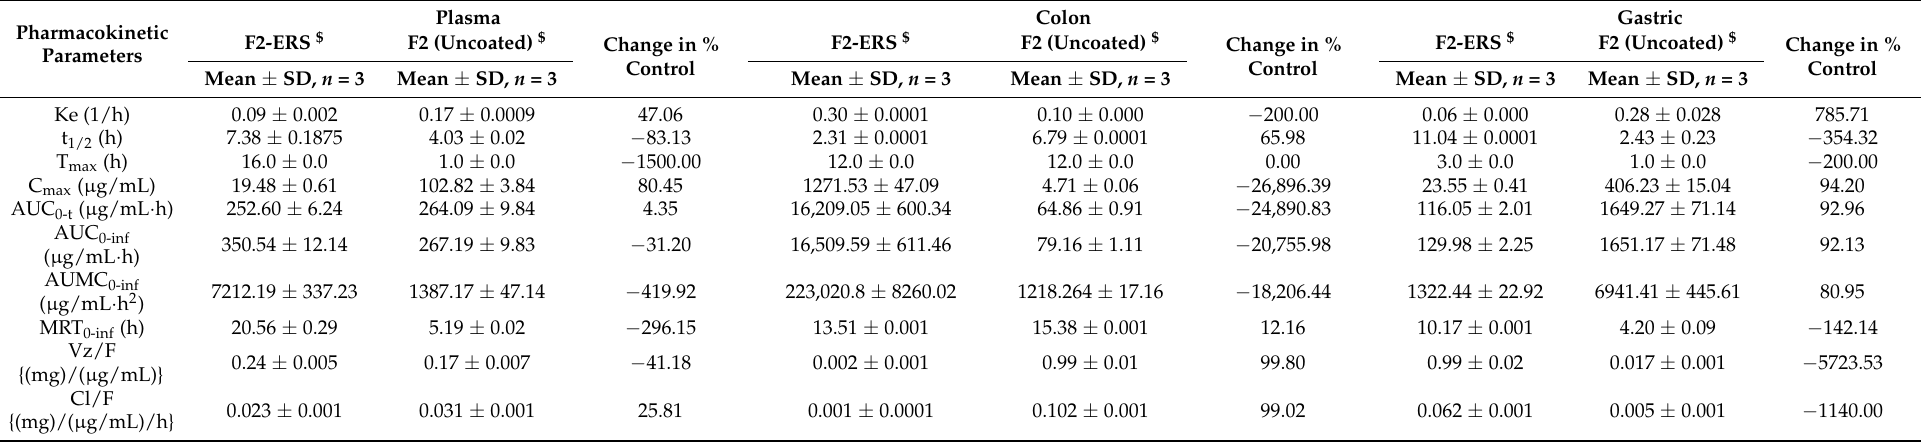
Table 3. Pharmacokinetic parameters of 5-FU from drug-loaded SEMC (F2-uncoated) and Eudragit RS-100-coated F2 (F2-ERS). Data were represented as mean SD, n = 3. All values represent mean ± SD. $ p < 0.05 (F2-Uncoated); ANOVA, followed by Dunnett’s